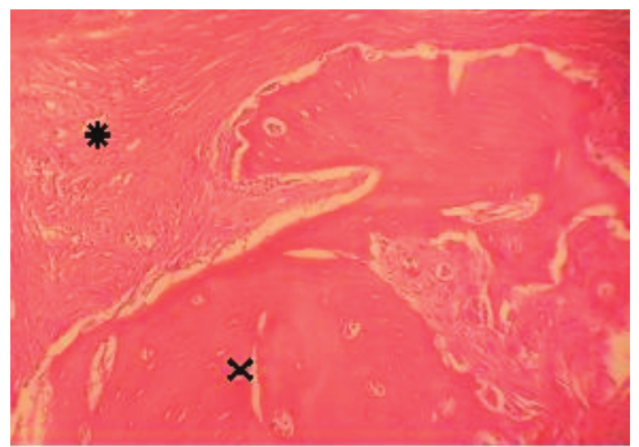
FIGURE 7 - It was observed tissue with fibrous-osteoid aspect ( * ) among bone tissue ( × ). HE x 250.